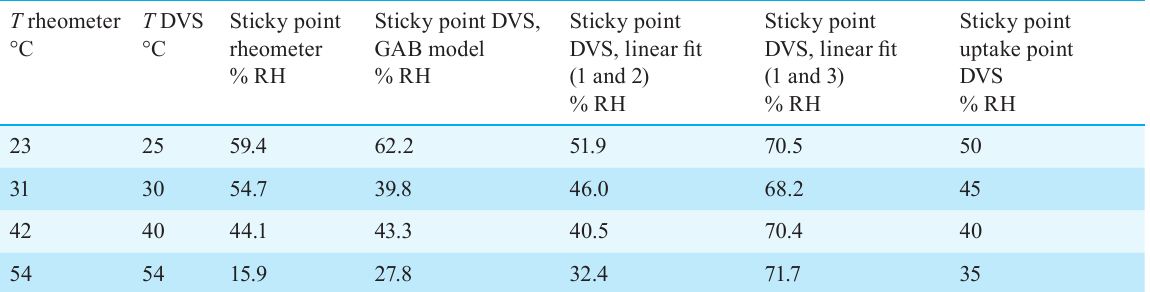
Fig. 3 Torque isotherms of the coffee creamer sample at 4 different temperatures, 23 °C, 31 °C, 42 °C and 54 °C, with the fitted regions in the isotherms obtained with the Anton Paar Rheometer technique. Table 1 Sticky point values for coffee creamer recorded via the powder rheometer methodology and derived from the water vapor sorption isotherms using the various methods, in the temperature range from 23–54